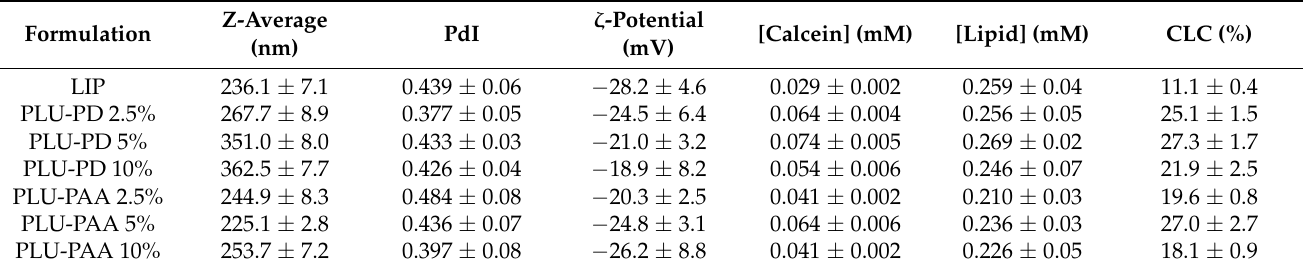
Figure 2. 1 H-NMR spectra of ( A ) Pluronic ® F68, ( B ) PLU-Br, ( C ) PLU-PtBA, ( D ) PLU-PAA and ( E ) PLU-PD, where (a) –CH 3 is the methyl protons of PPO units; (b) –CH is the methine proton of PPO units; (c) –CH 2 is the methylene proton of PEO units; (d) CH 3 C–Br, from 2-bromo-2-methylpropionyl group; (e) –C(CH 3 ) is the methyl protons of tBA units; (f) N–CH 3 is the methyl protons of DMAEMA units; (g) N–CH 2 is the methylene protons of DMAEMA units; (h) H 2 C–O–C=O is the methylene protons of DMAEMA units; (i) −CH 2 − from PDMAEMA backbone. Table 1. Physical characterization of LIPs and PLCs at 37 ◦ C and pH = 7. Molar concentration of encapsulated calcein, molar concentration of lipids and CLC. Data denoted as mean ± standard deviation (SD), n =